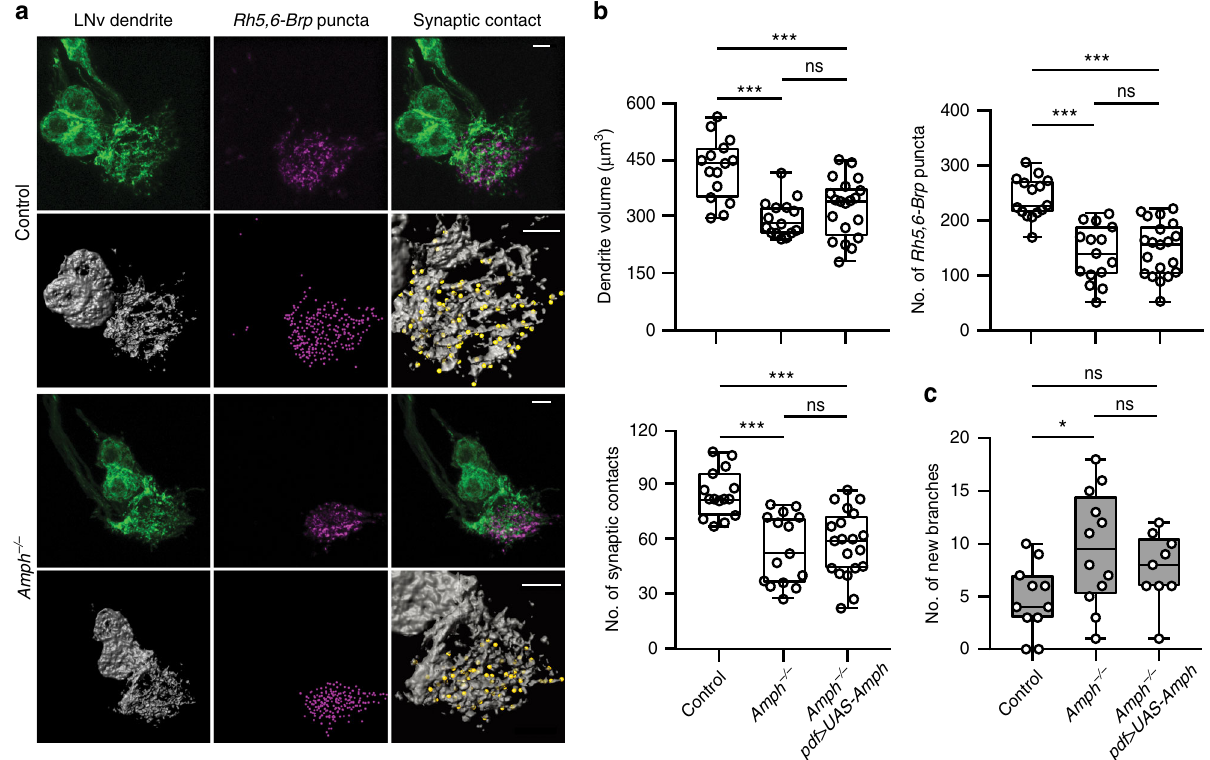
Fig. 7 Drosophila Amph regulates the dynamic state of LNv dendrites cell-autonomously. a Compared to the background control, amph null mutants ( Amph − / − ) have signi fi cant reductions of dendrite volume (green or gray), the number of presynaptic terminals (magenta), and synaptic contacts (yellow spots). Representative projected confocal images (Top) or 3D reconstructions (Bottom) are shown. Genotypes are as indicated. Scale bar, 5 μ m. b